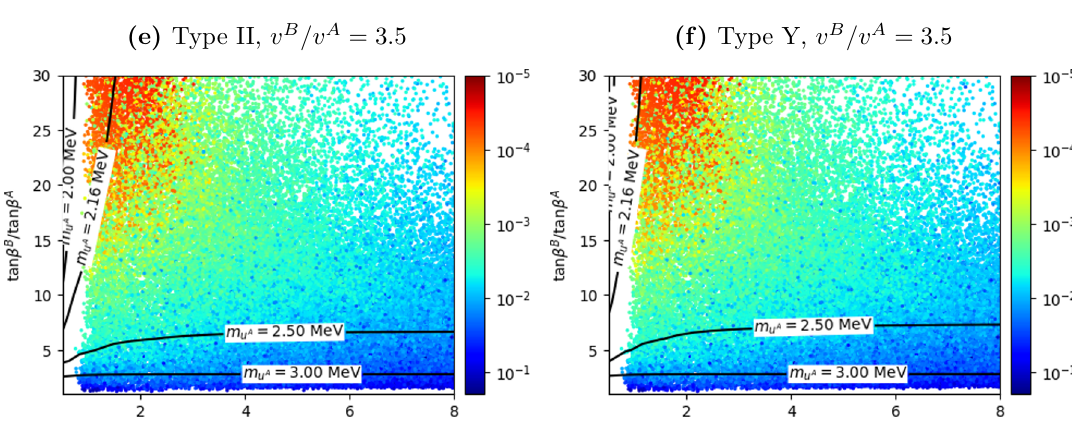
Figure 4. Contours of X DA = 10% for di(cid:11)erent m r T = 0 : 45. The colour corresponds to the minimum of T (cid:18)